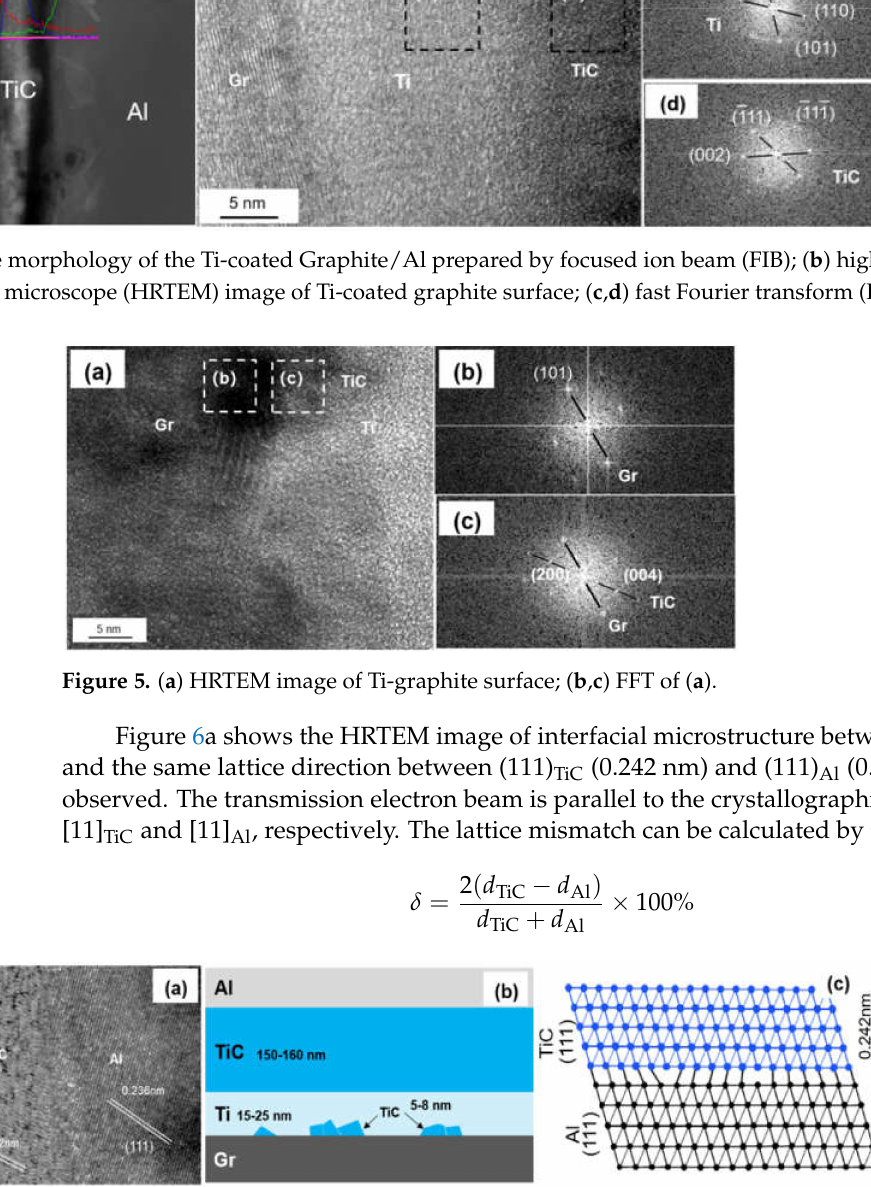
Figure 6. ( a ) HRTEM image of the TiC/Al interface; ( b ) Schematic drawing of interfacial structure of the Graphite/Al (Ti) composites; ( c ) Schematic diagram of the TiC/Al interfacial